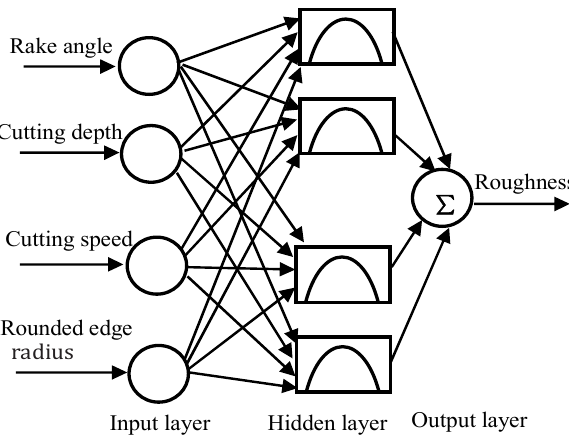
Figure 2. Schematic of artificial network topological structure.